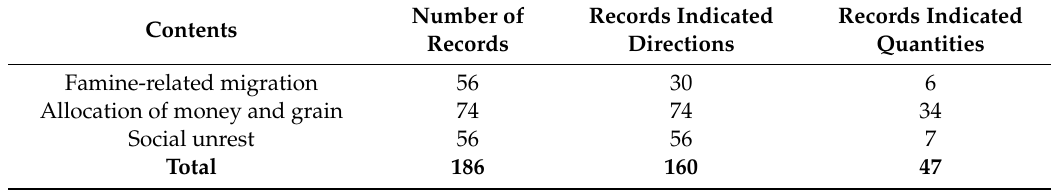
Table 1. Classification of the historical records for the North China Famine of 1876–1879.